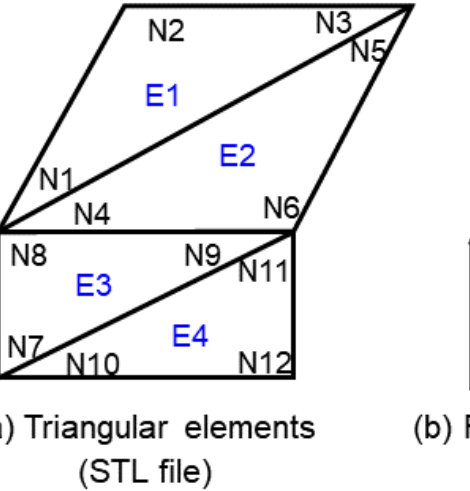
Figure 3. Removal of duplicated nodes.